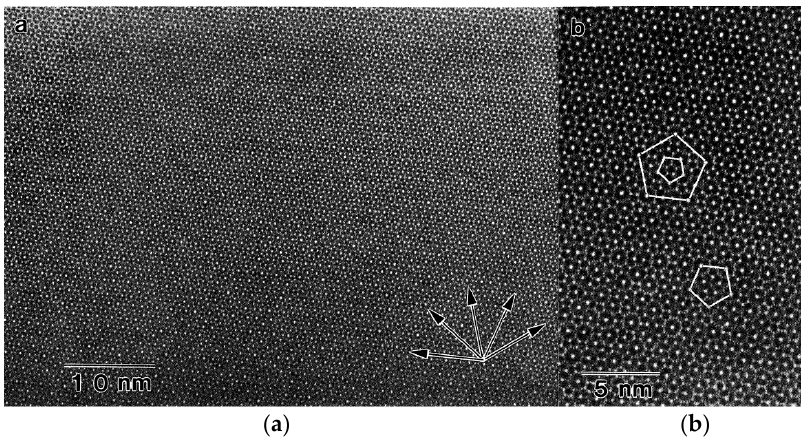
Figure 5. HRTEM image taken along the 5-fold axis of icosahedral Al–Cu–Fe: ( a ) aperiodic but ordered distribution of bright dots; ( b ) enlargement of ( a ). The five arrows in ( a ) show that bright dots are lying along 5-fold symmetry directions; the pentagons in ( b ) indicate that bright dots can form pentagons of different sizes (reproduced from reference [33] with permission. Copyright 1988 The Japan Society of Applied Physics).